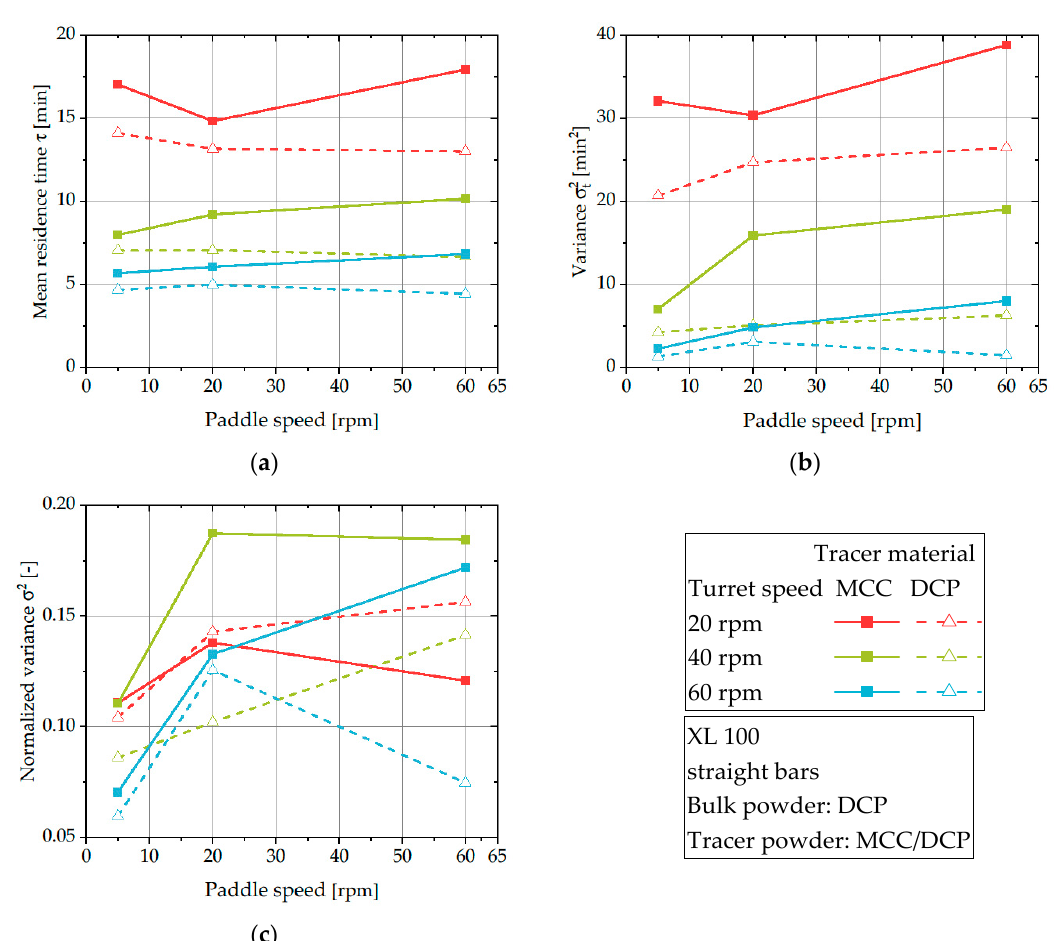
Figure 8. Mean residence time ( a ), variance ( b ), and normalized variance ( c ) of DCP and MCC acting as tracer material in a DCP bulk on the XL 100 for different levels of turret and paddle speed.